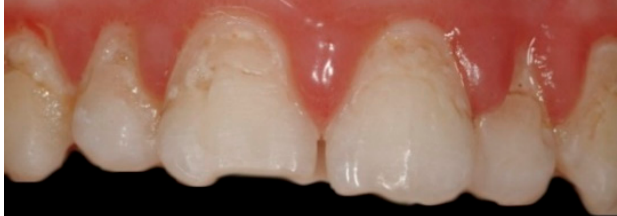
Figure 7. Is the original photo.